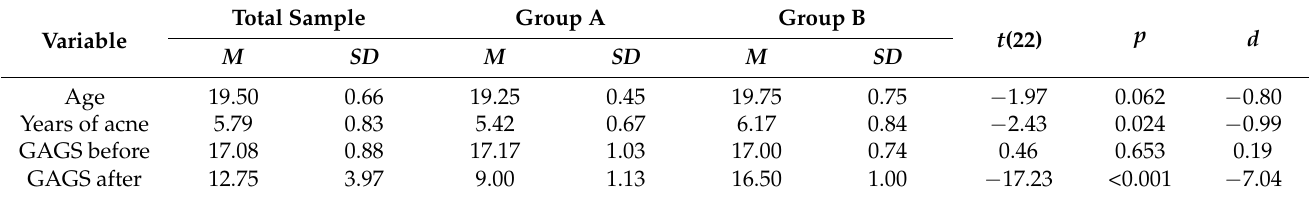
Table 1. Descriptive statistics.